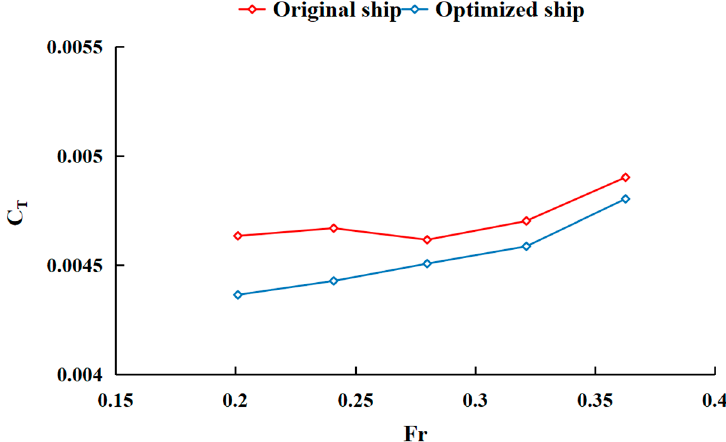
Figure 17. Total resistance coefficient changes with ship speeds for different ship models.